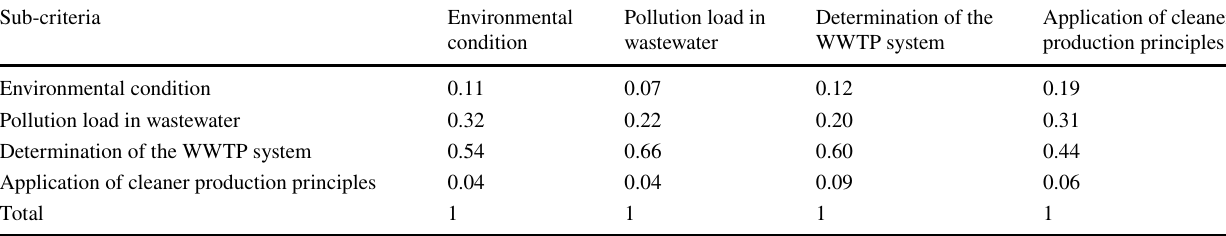
Table 6 Normalization sub-criteria pairwise comparison matrix Sub-criteria